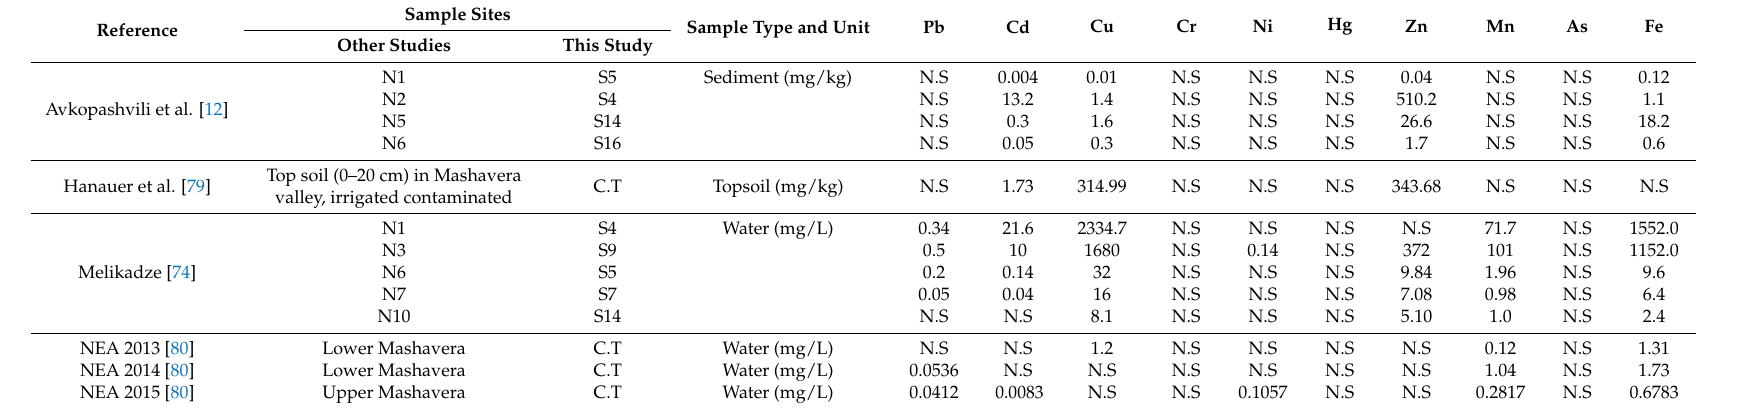
Table 9. Heavy metals concentrations in the Mashavera River Basin according to other